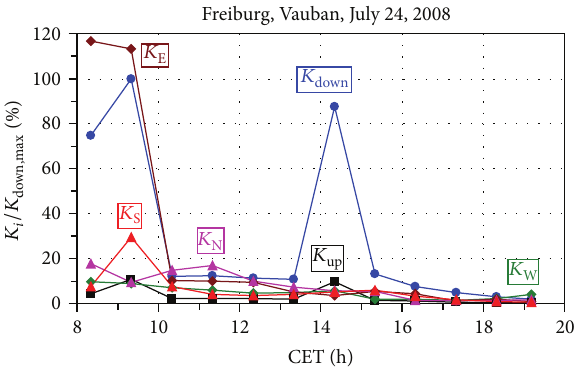
( 𝐾 = down , abs down , abs , max